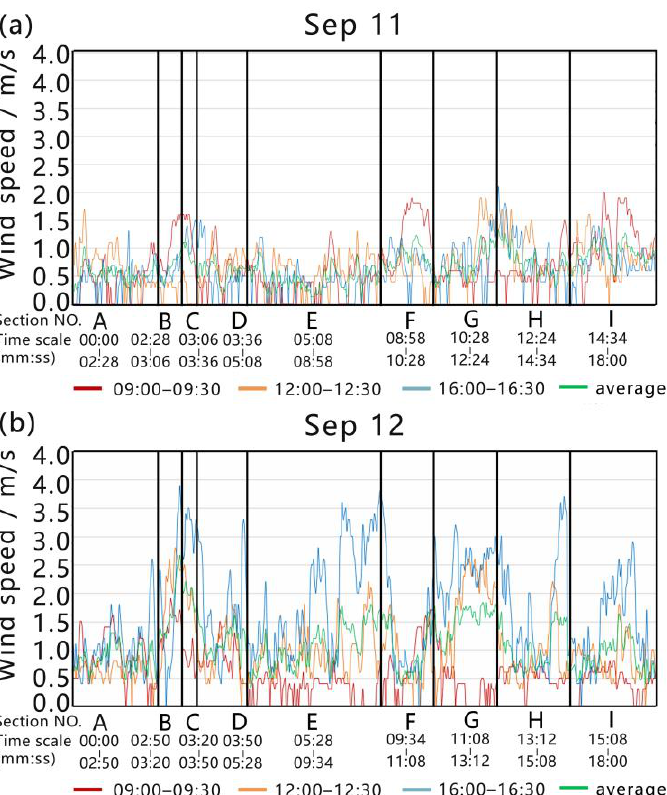
Figure 9. The line charts depicting the wind speed changes over three time periods on 11 September (a) and 12 September